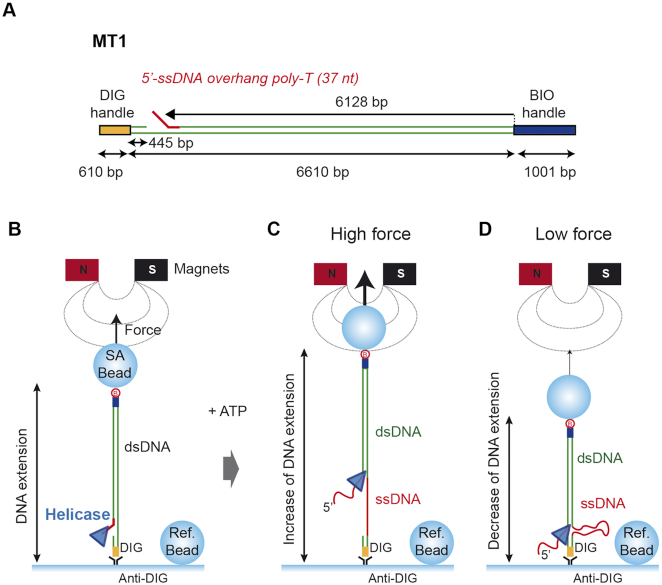
Magnetic Tweezers assay for monitoring DNA unwinding by Bad. (A) Schematic representation of the MT1 DNA substrate employed for the single molecule unwinding assay. It contains two handles labelled with biotins and digoxigenins which bind to the magnetic bead and glass surface, respectively. The insert (∼6.6 kb) contains a 5′-ssDNA overhang at ∼6.1 kb from the biotinylated DNA end opposing a short ssDNA gap of 37 ntds. (B) In the experimental set-up, tethered DNA molecules are incubated with Bad proteins in the flow cell and Bad is loaded onto the 5′-ssDNA overhang. Note that, when a protein displays canonical NA unwinding (helicase) activity, the bead is expected to either (C) increase in height if the restraining force on the bead is high (i.e. ≥6 pN, because ssDNA is longer than dsDNA under these conditions) or (D) decrease in height under a low force regime (i.e. ≤6 pN, in which ssDNA is compacted compared to duplex).